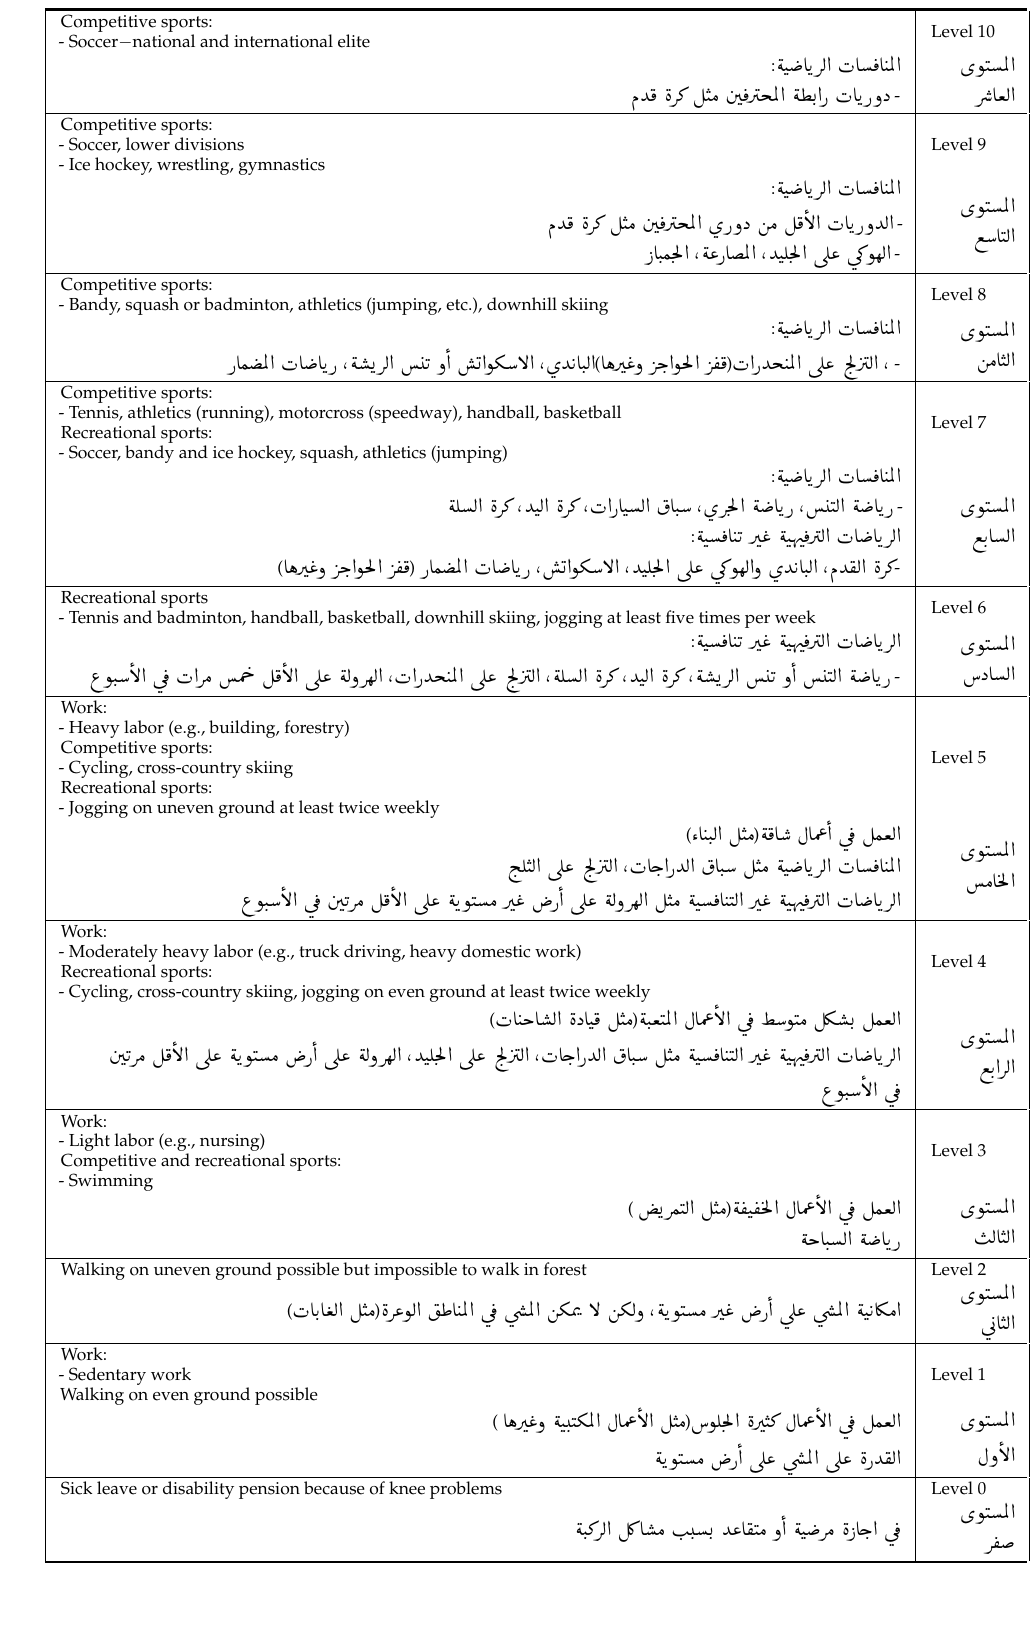
Table 1. The Arabic version of the Tegner Activity scale